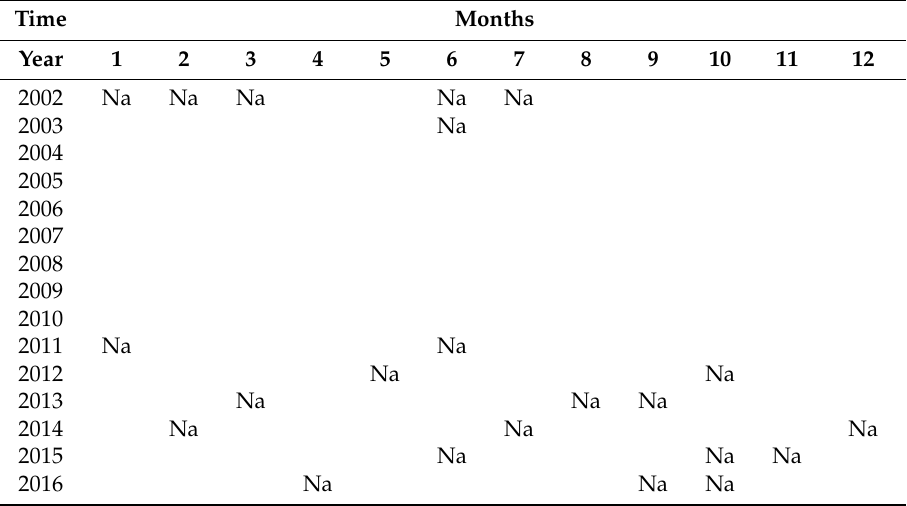
Table 1. The corresponding time to the missing data from January 2002 to December 2016.